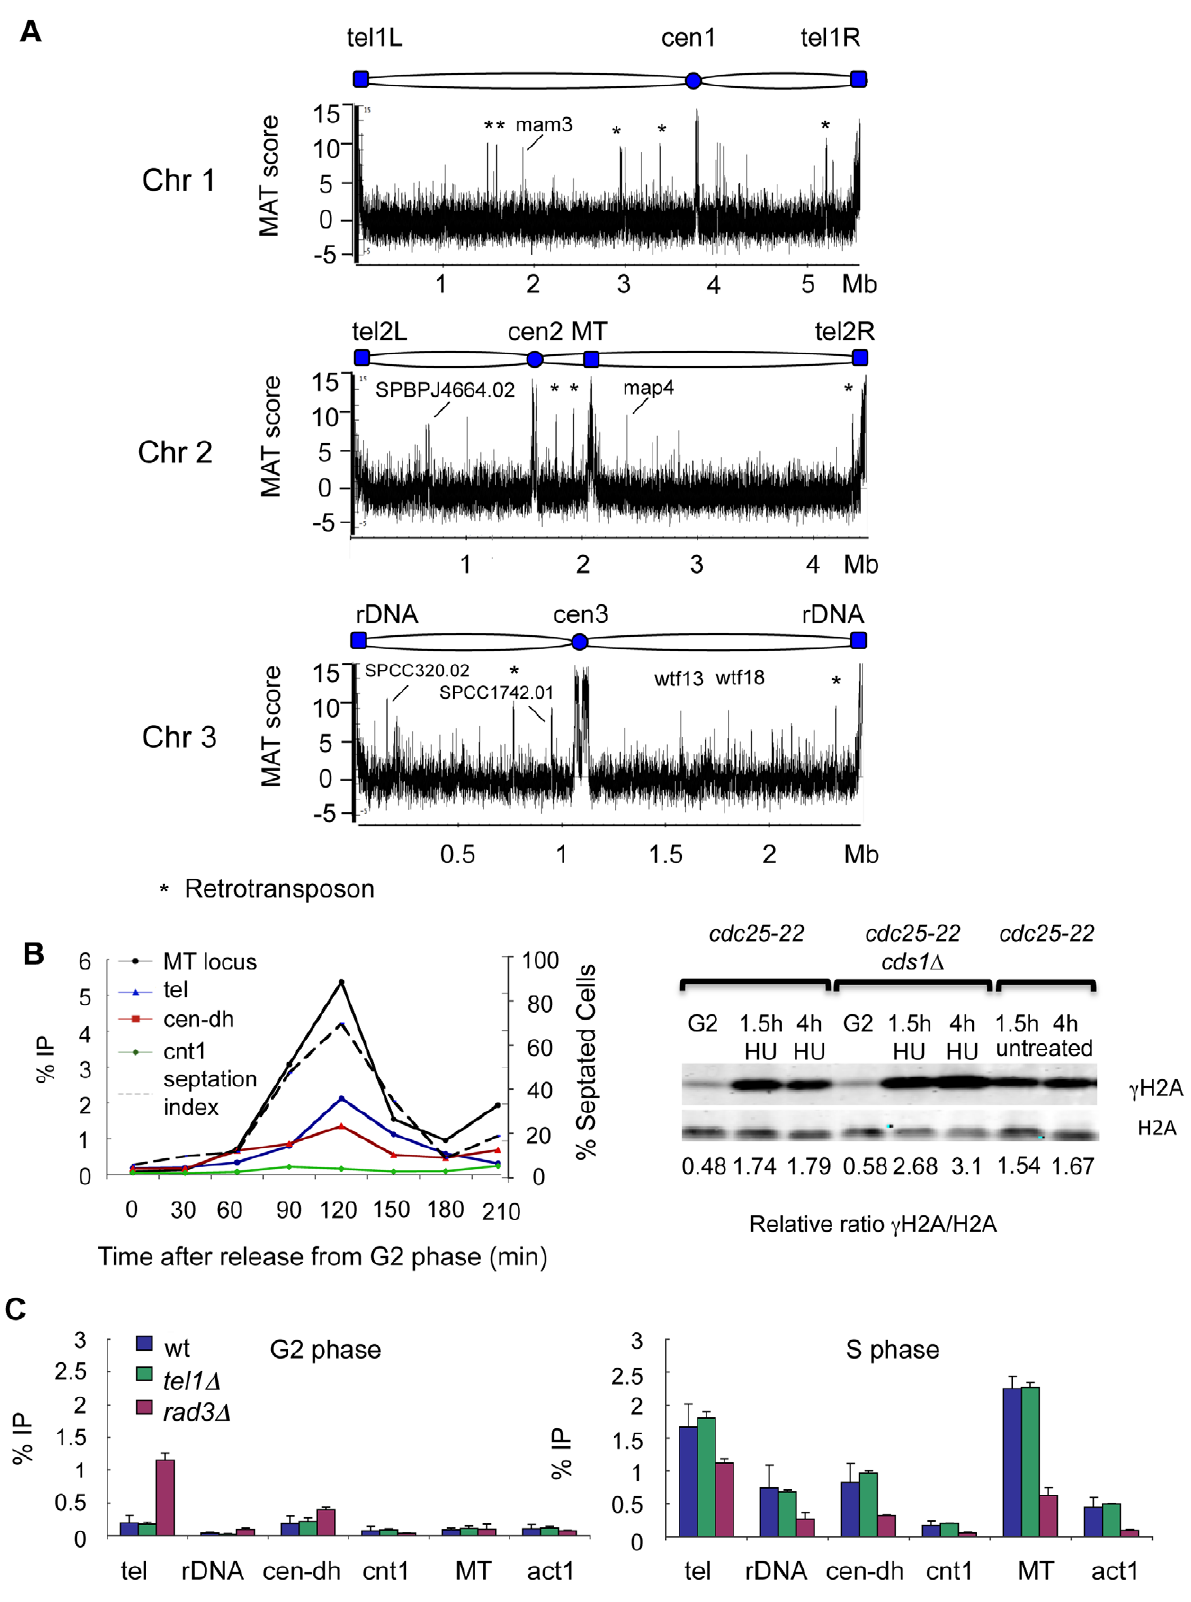
Figure 2. Genome-wide localization of c H2A during DNA replication. (A) Genome-wide (ChIP-on-chip) distribution of c H2A during S phase. Schematics represent the three S. pombe chromosomes with key structural features (top). Tel- telomere; cen-centromere; MT-mating-type locus; rDNA-ribosomal DNA. Enrichment of c H2A is displayed as MAT scores (y-axis). Chromosome coordinates (x-axis, in megabases, (Mb)) downloaded from the S.pombe Genome Project (Sanger Center: www.sanger.ac.uk/Projects/S_pombe). (B) (left) c H2A formation occurs specifically during S phase.